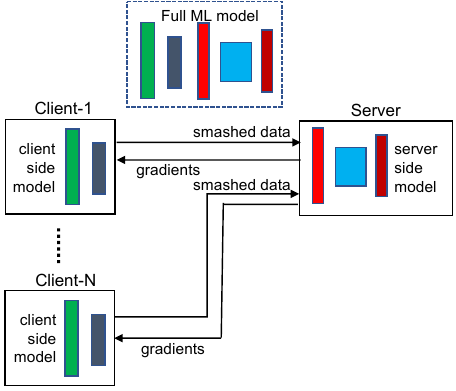
Figure 2. Framework architecture for multi-client split learning.